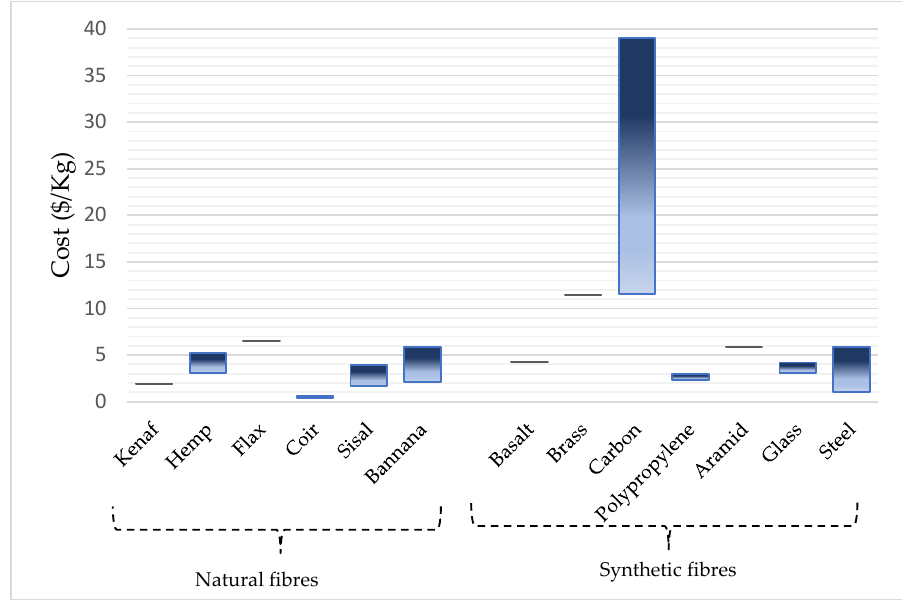
Figure 5. Cost comparison between natural and synthetic fibres. Table 1. Energy input of FRP composition [33,35].